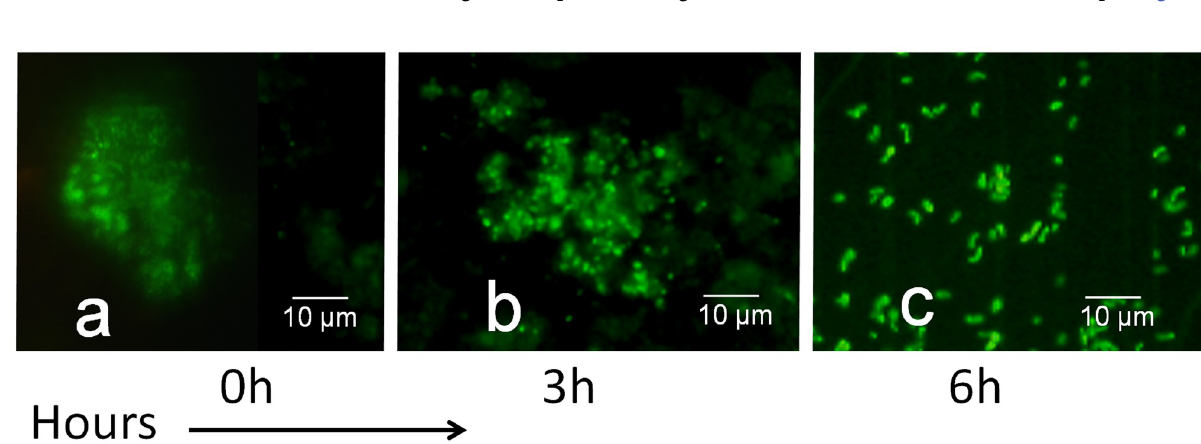
Table 2. Recovery of dormant V . cholerae O1 CVEC in environmental water by culturing in medium supplemented with spent culture supernatant of various bacte- rial strains and genetic constructs. Date of No. of Number of samples found positive for V . cholerae O1 after enrichment in LB containing filter- sterilized spent medium a of different sampling samples tested b